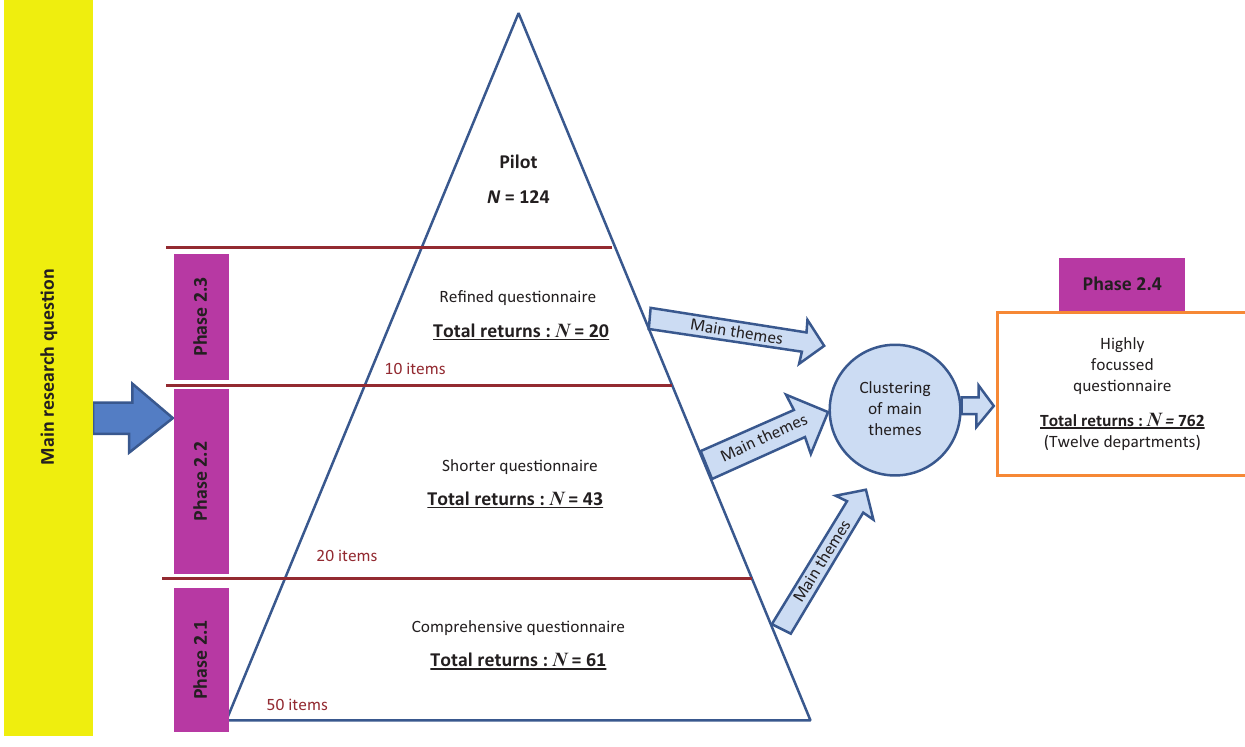
FIGURE 4: Quantitative multiphase process used for the pilot, the participants were n = 124 participants and for the purpose of this research’s final questionnaire the participants were n = 762